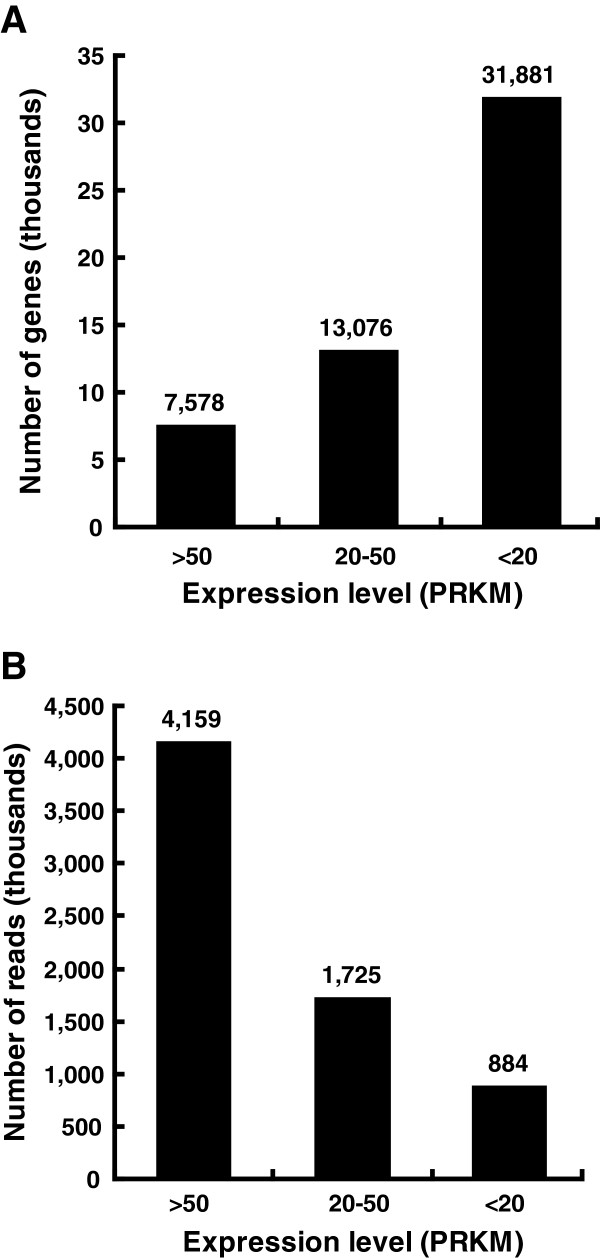
Levels of gene expression of Asia II 3 transcriptome.A. Percentages of Asia II 3 genes that belong to high (RPKM>50), medium (50>RPKM>20) and low (RPKM<20) expression levels based on the total number of Reads Per Kilobase per Million mapped reads (RPKM). B. Numbers of reads mapped to the genes of high (RPKM>50), medium (50>RPKM>20) and low (RPKM<20) expression levels. The exact values are shown on the top of each bar.